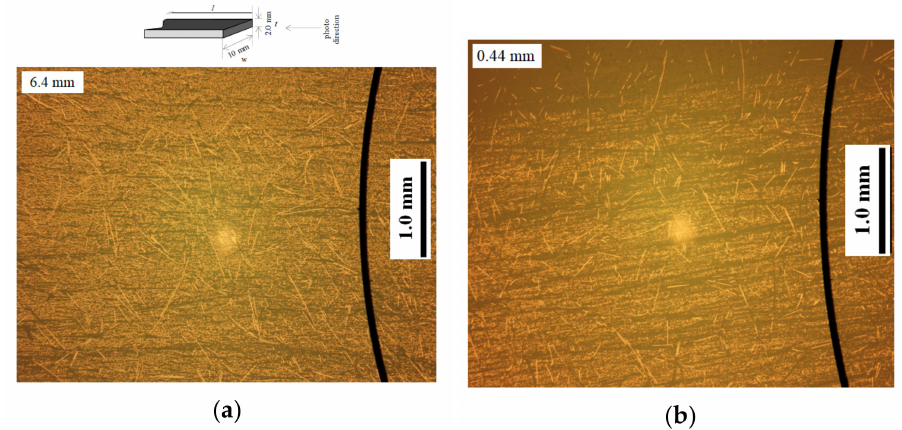
Figure 5. Optical microscope photos from center A-sections for: ( a ) nominal 6.4 mm, and ( b ) 0.44 mm BMC samples, respectively, and a diagram of optical microscopy